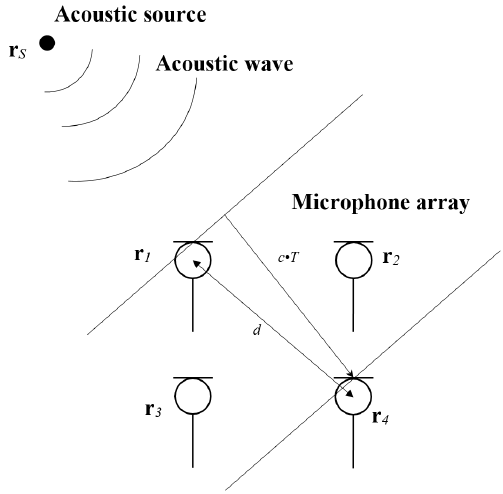
Figure 12. Spatial representation of the microphone array.